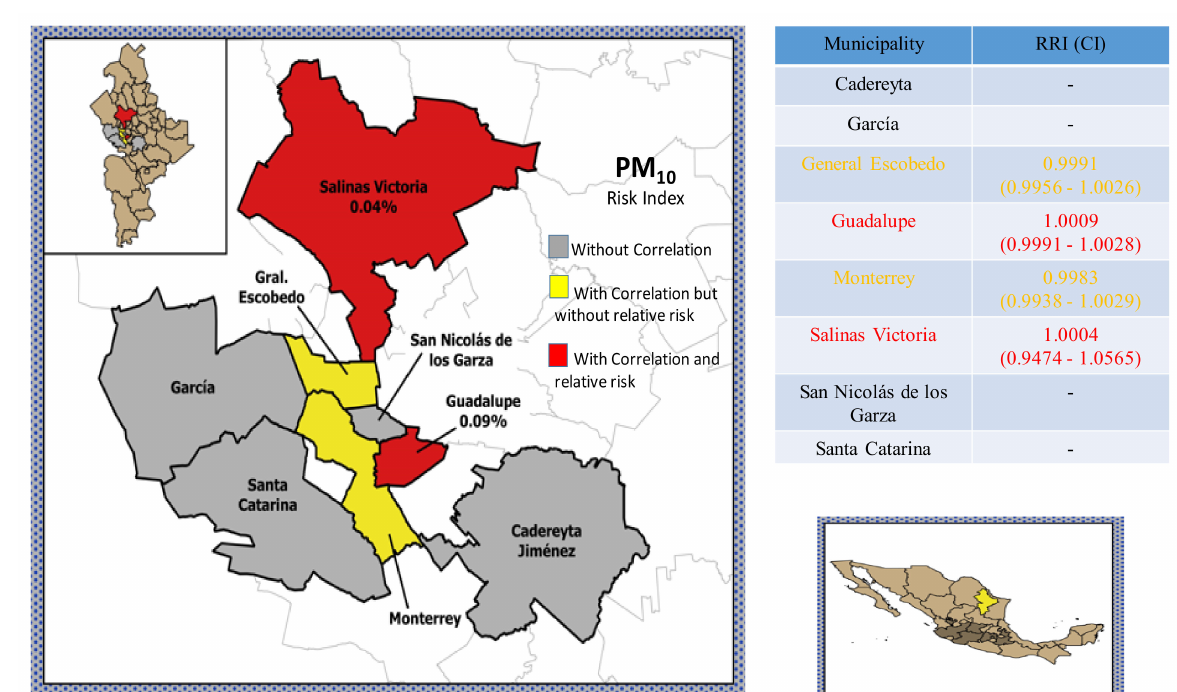
Figure 14. Relative risk indexes in MAM for the hypothetical scenario in which daily mean concentrations for PM 10 increased by 10%, considering all